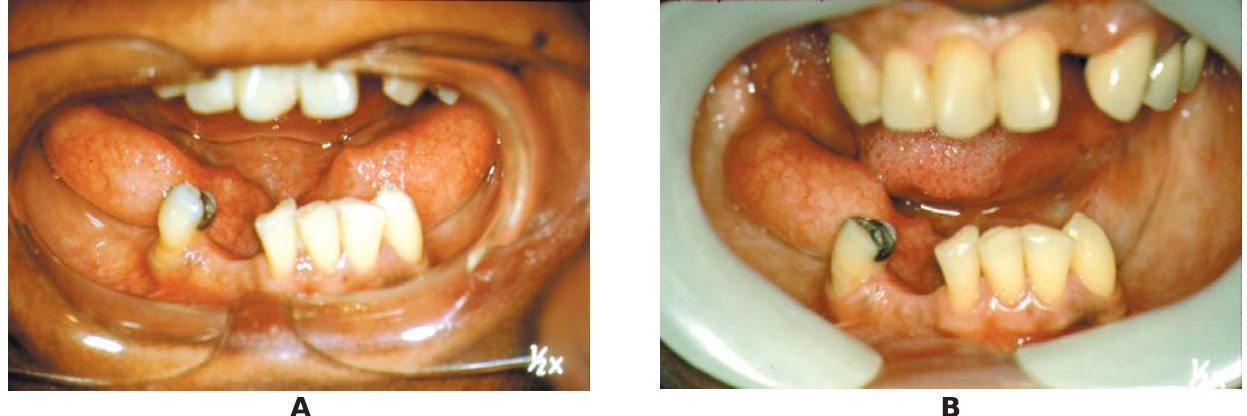
FIGURE 1- Mouth floor enlargement in a fifty-eight years old woman. A: Bilateral mouth floor enlargement. B: 15 days post- surgery control (left